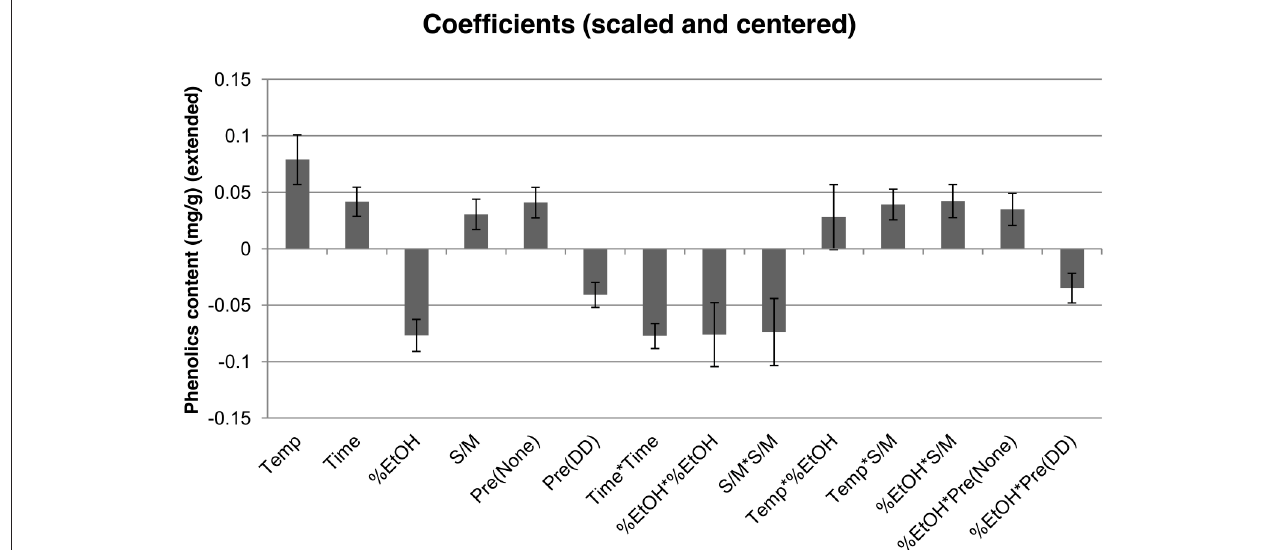
FIGURE 4 | Regression coefficients of phenolic content model. Model coefficients are scaled and centered.